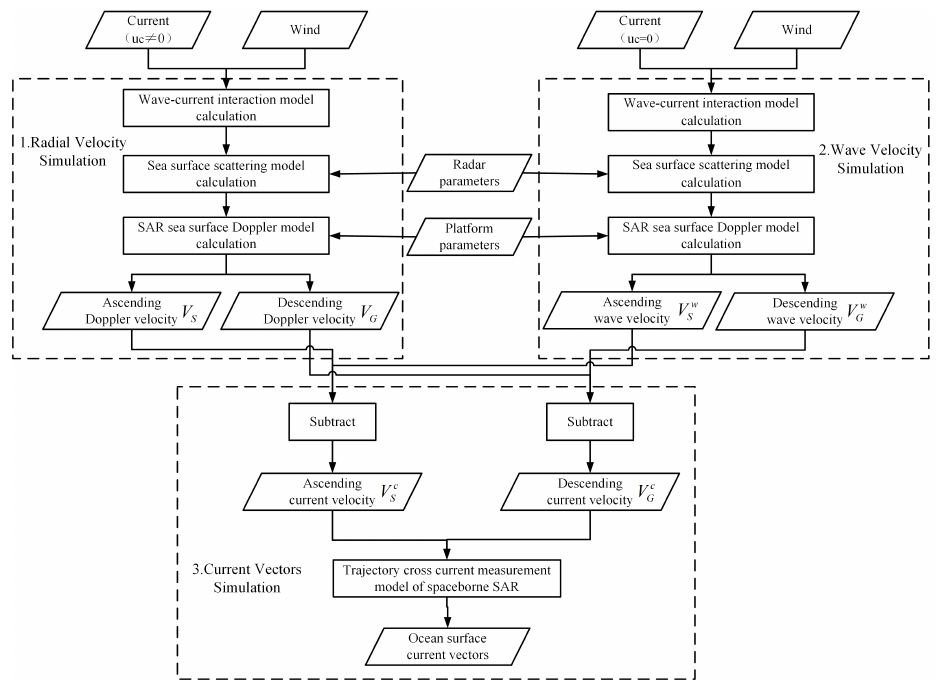
Figure 2. Flow chart of two-dimensional sea-surface-current-field simulation for trajectory crossing spaceborne